Question: Looking at the figure, what chart type is it?
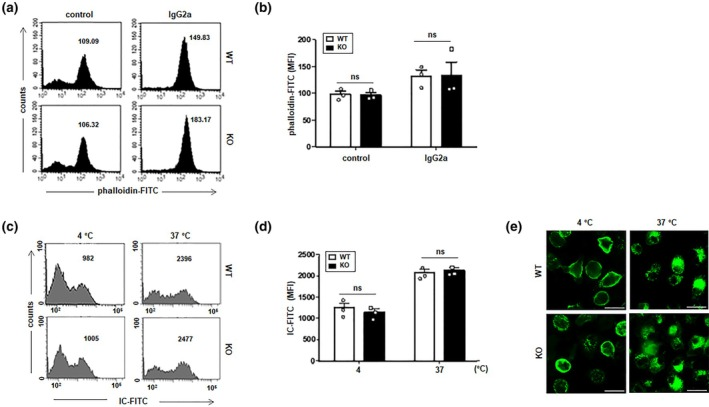
Answer: histogram